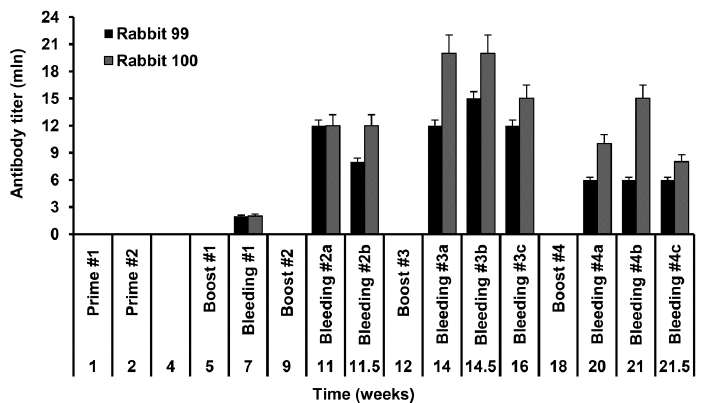
Figure 2. Level of anti-S-HDAg antibodies in the sera of Shinchilla grey rabbits immunized with the His-tagged S-HDAg. Data is presented as the end-point antibody titer. X -axis depicts time points of immunizations and bleedings in weeks.